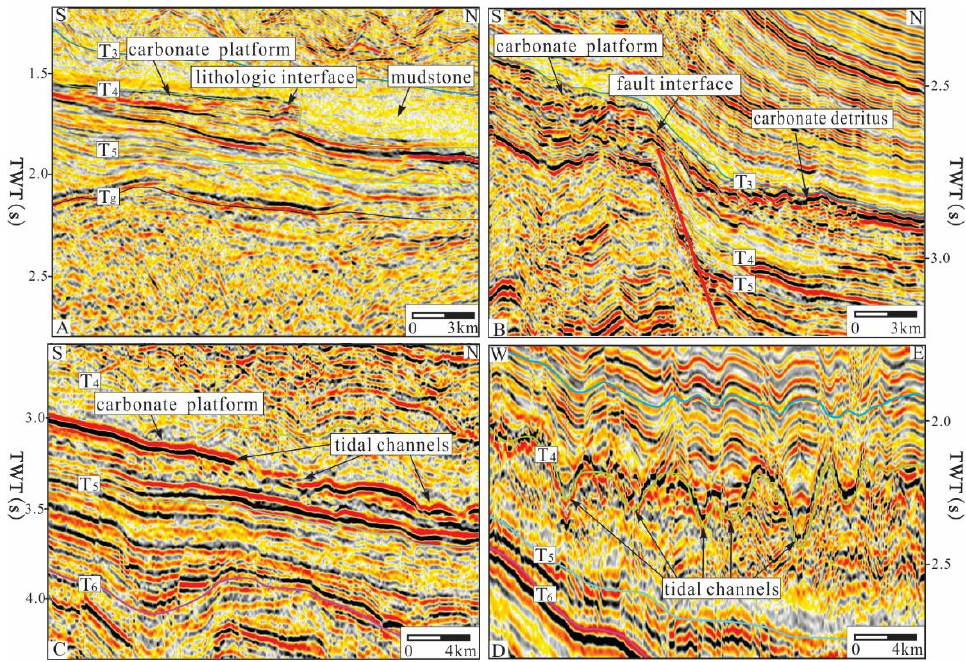
Figure 6. Marginal symbols of the carbonate platform in the Xisha sea area: ( A ) lithologic interface; ( B ) fault interface; ( C , D ) tidal channels. The locations are shown in Figure 1B.